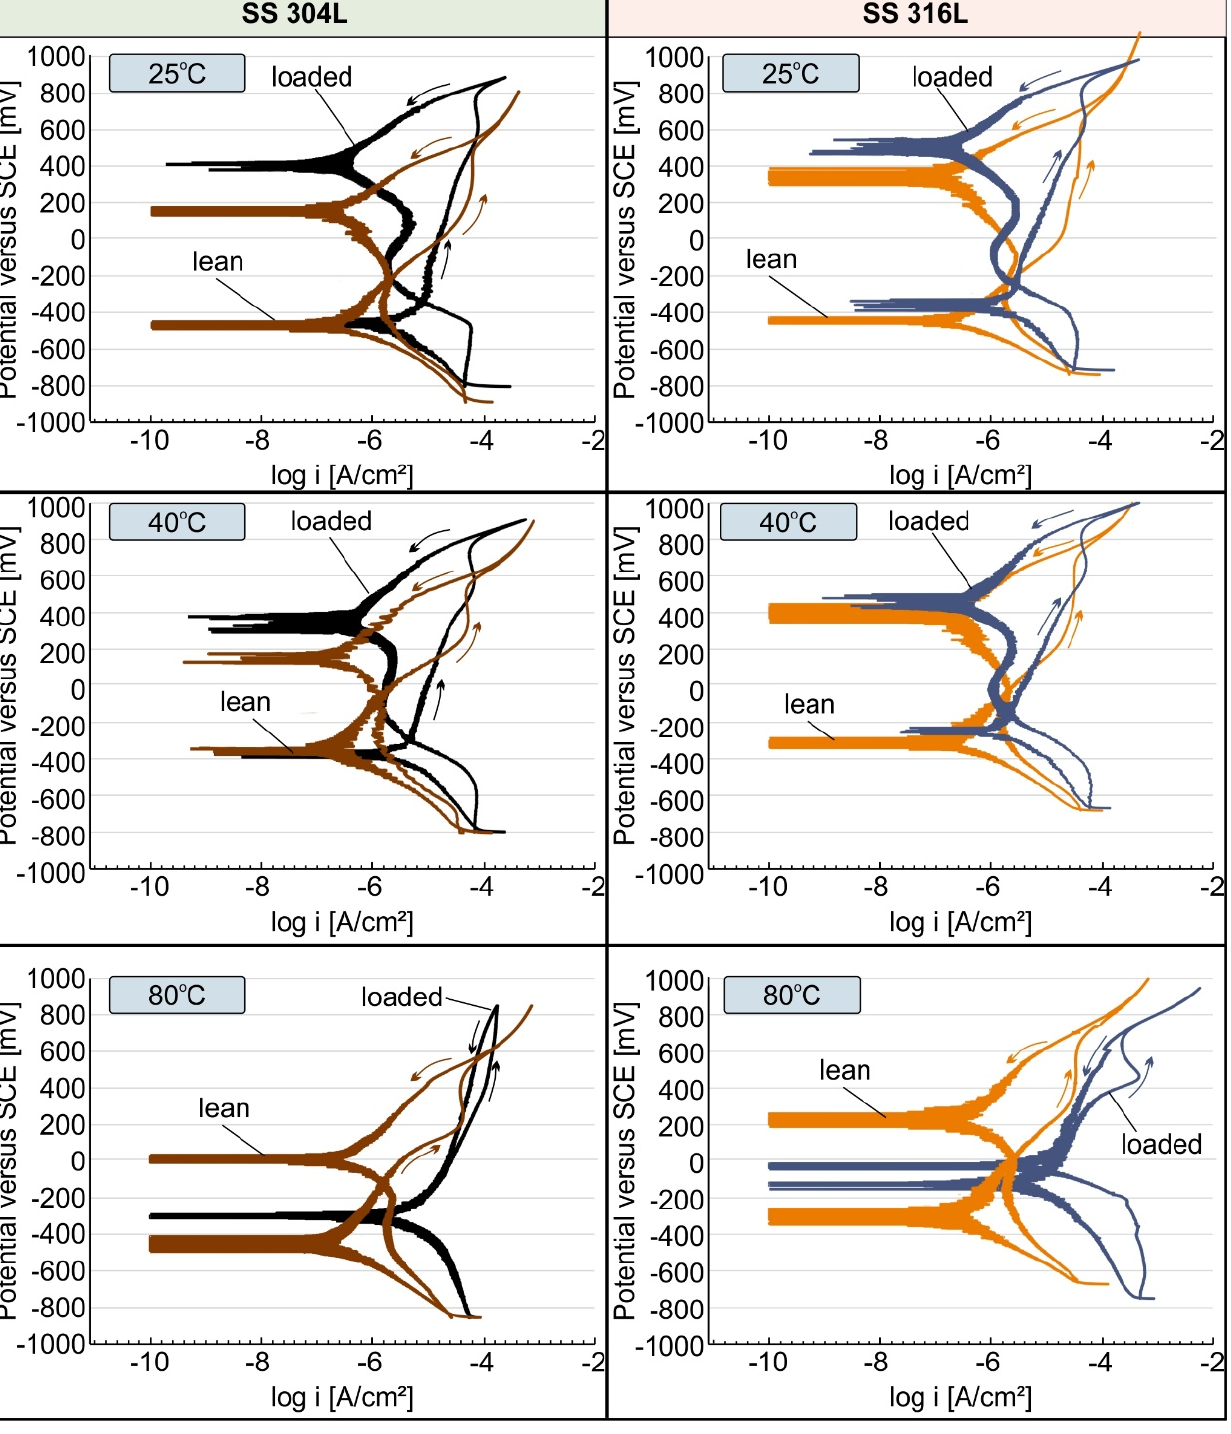
Figure 5. Cyclic polarization curves for SS 304L and SS 316L at 25 °C, 40 °C and 80 °C when immersed in unloaded and loaded MEA solution.